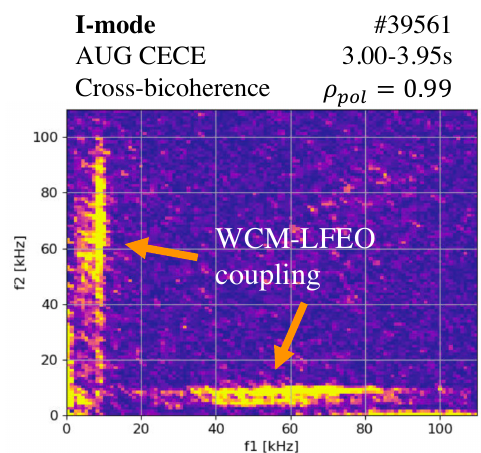
Figure 3. Cross-bicoherence of neighboring CECE channels near the WCM peak location of ρ pol = 0 . 99. Coupling is seen between the WCM (40-80 kHz) and the LFEO (8 kHz). FFT bins of 4096 were used for the analysis with 1855 overlapping